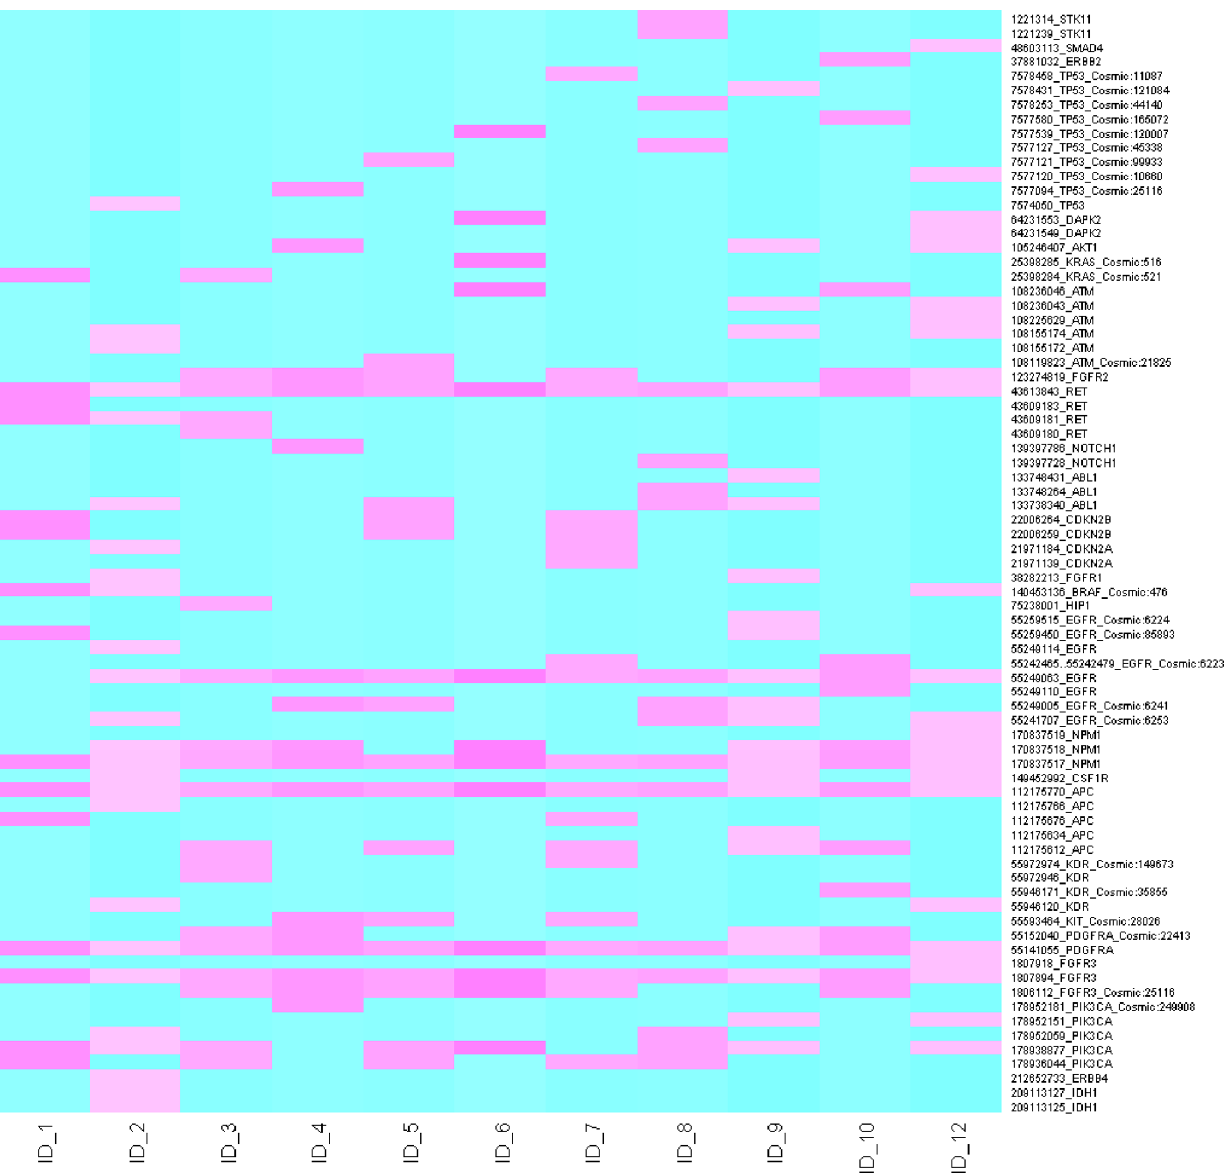
Figure 1. Distribution of variants detected using the Ion AmpliSeq Cancer Panel. A heat map was generated illustrating the variants occurring in all 46 genes by both IonTorrent software versions in each of the clinical samples. COSMIC tracked variants are also